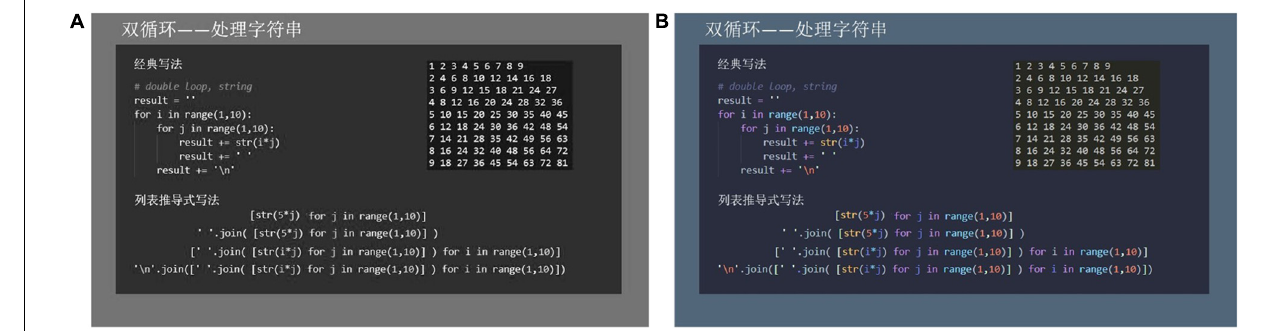
FIGURE 1 | Two slide-based video lectures in (A) grayscale design and (B) color-coded